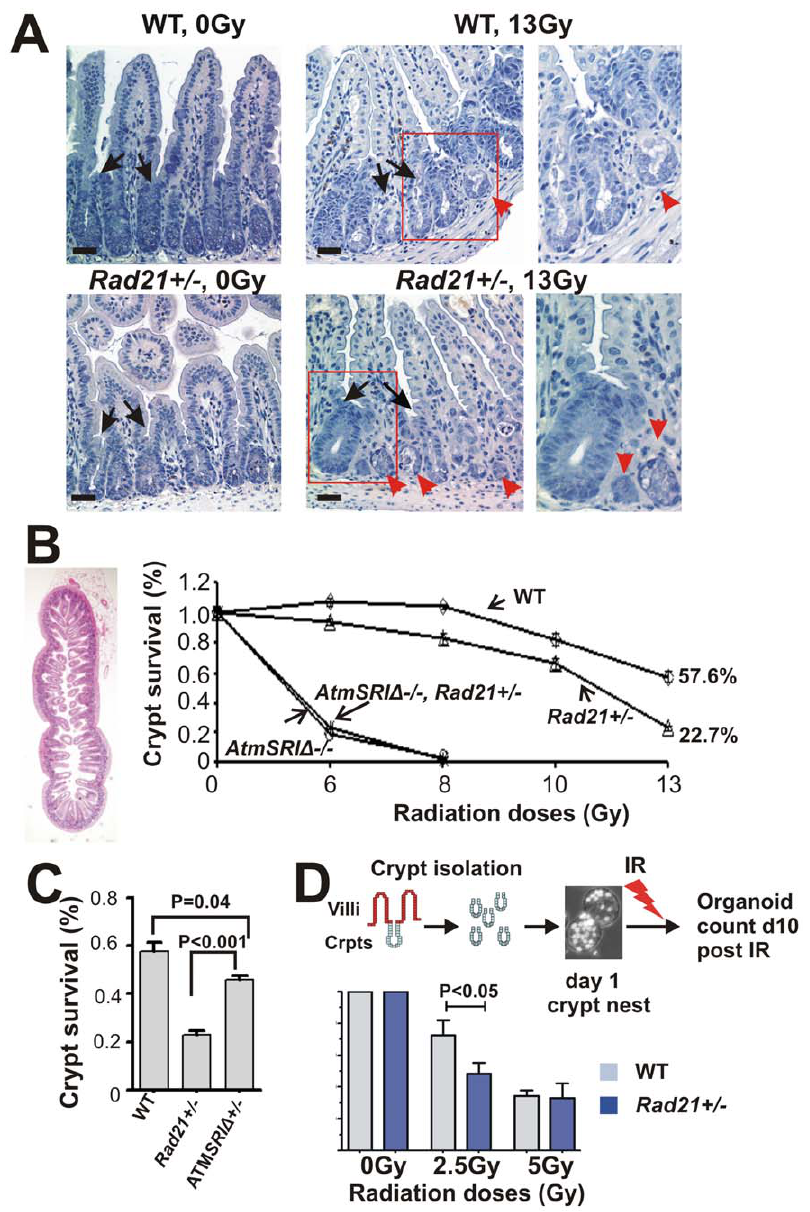
Figure 4. Invivo and exvivo small intestinal crypt survival following radiation exposure. A . Hematoxylin-stained transverse sections of small intestines. Representative images of small intestinal crypts of unirradiated and irradiated animals. Irradiated samples shown were obtained at 3.5 days post 13Gy WBI. Non-surviving crypts are indicated by red arrowheads and surviving crypts by black arrows. Right panels: enlarged images from boxed areas. Scale bars=20 m m. B . Crypt survival determined by the microcolony assay. Surviving crypts were counted 3.5 days post WBI at incremental doses as shown, in at least six whole circumferences of small intestine cross-sections (left panel) and expressed relative to unirradiated animals. The number of animals used for each data point is listed in Table S1. Error bars=SEM. C . Comparison of crypt survival in Rad21 and Atm mutant animals 3.5 days post 13Gy WBI. WT and Rad21 + / 2 data shown areas in B. The number of animals used is as follows: Rad21 + / 2 : n=7; AtmSRI D + / 2 : n=5; WT: n=7. Error bars=SEM. D . Ex vivo crypt organoid survival. Diagrammatic presentation of the assay is shown above the graph. Day 1 organoid nuclei were visualised with Hoechst 33258 to show live cells. Data represent the percentage of organoids formed 10 days post IR at the doses indicated relative to unirradiated controls. The number of animals used is as follows: WT: n=5; Rad21 + / 2 : n=7; four replicates were counted for each animal. Error bars=SEM.